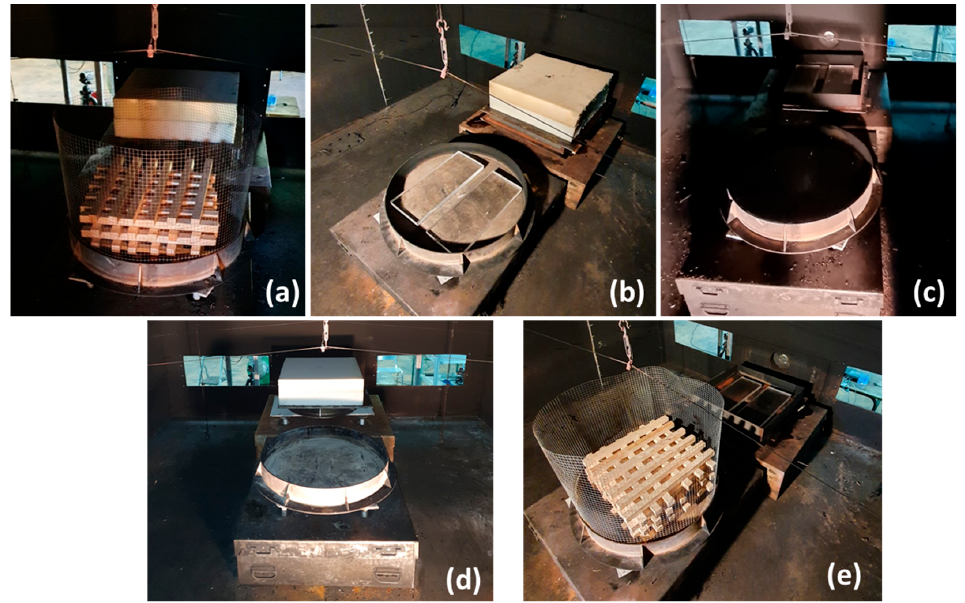
Figure 8. Fire sources involving ( a ) DUF and PUF (tests 1 and 6), ( b ) PMMA and PUF (tests 2 and 7), ( c ) heptane and PMMA (tests 3 and 8), ( d ) heptane and PUF (4 and 9), and ( e ) DUF and PMMA (tests 5 and 10).